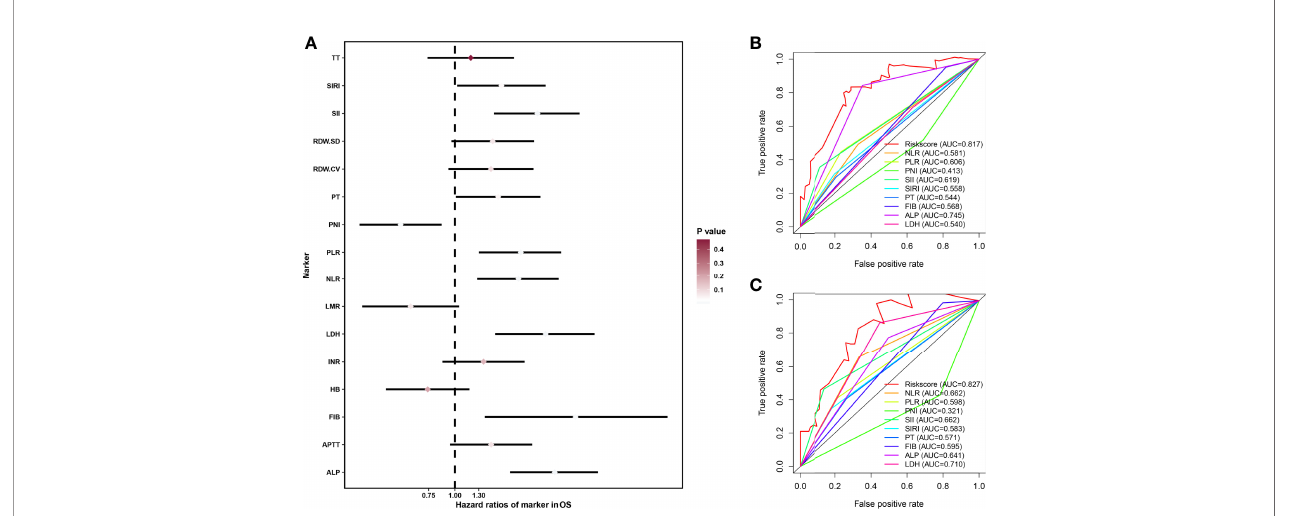
FIGURE 1 | Construction of HPSS and its comparison with individual hematological parameters. (A) Forest plot showing the results of univariate cox regression analysis of 16 hematological markers; (B) ROC curves showing the predictive power of HPSS in the training set versus a single hematology indicator; (C) ROC curves showing the predictive power of HPSS in the validation set versus a single hematology